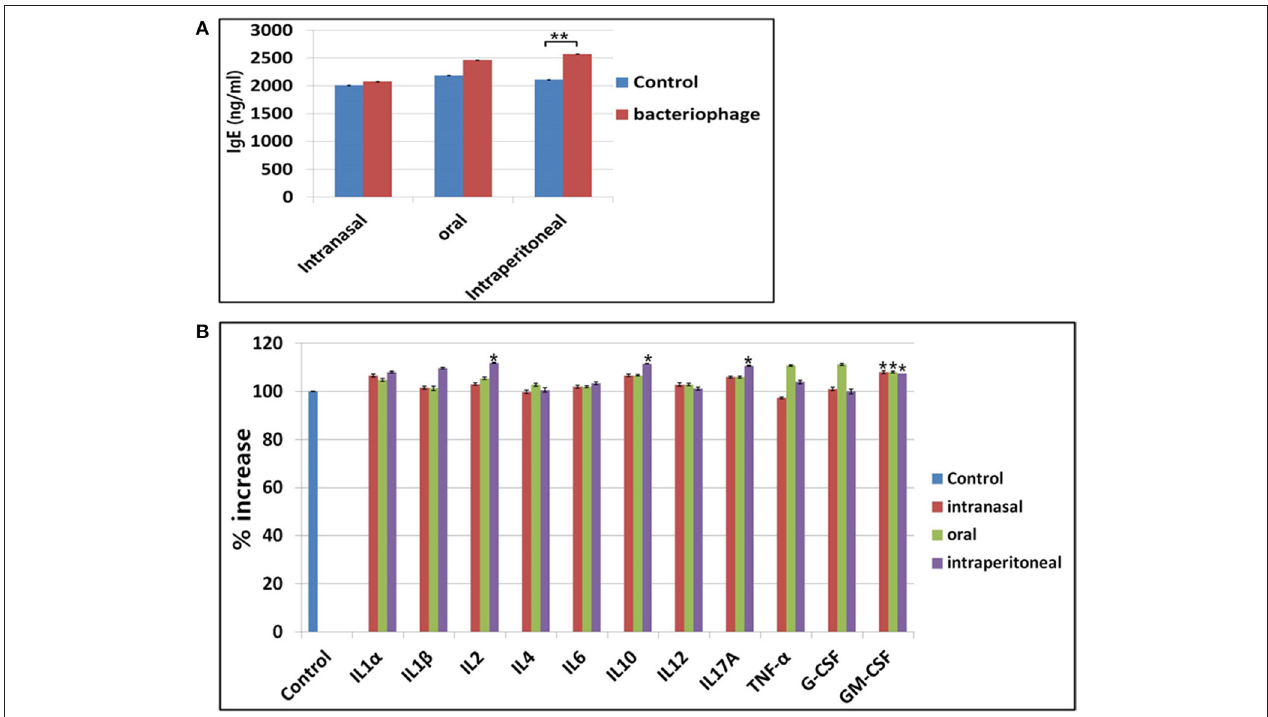
FIGURE 7 | Observation of immune responses against phage treatment in mice. (A) Changes in IgE production after treatment of phages in three different routes. (B) Changes in cytokine production after phage treatment in intranasal, oral, or intraperitoneal route. * P < 0.05, ** P < 0.01.